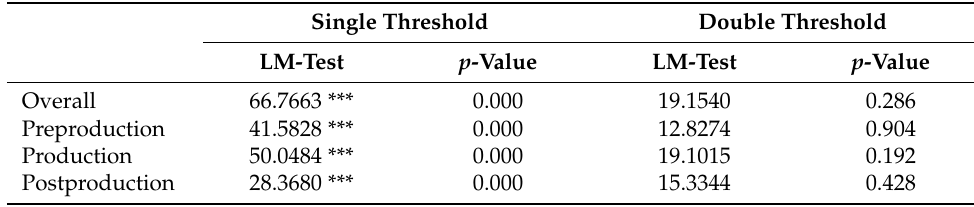
Table 4. Threshold effect test